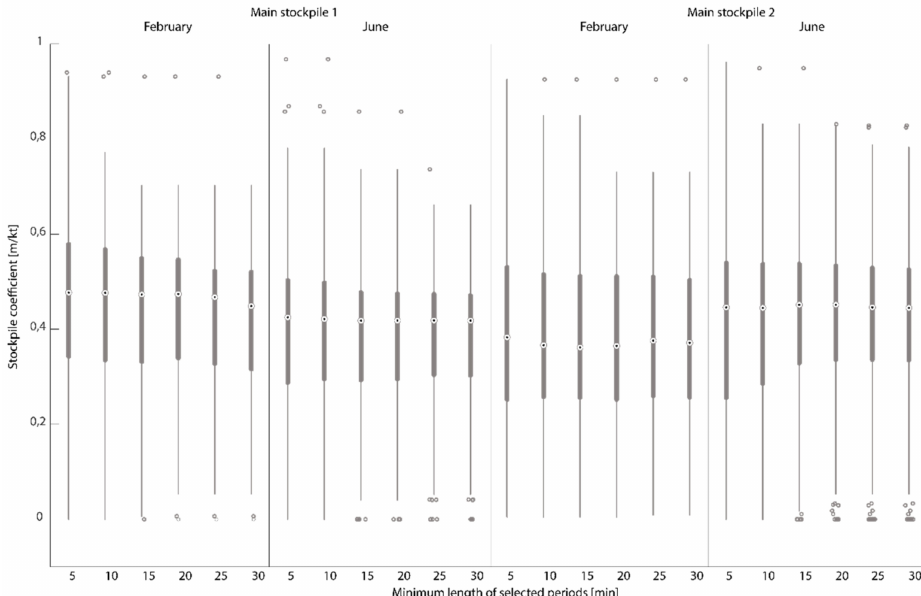
Figure 9. Analysis of variance of the main stockpile coefficients for the different minimum durations.